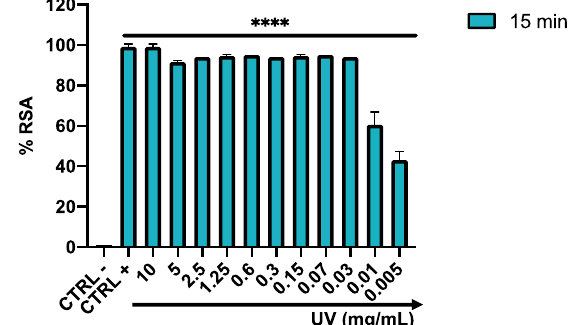
Figure 9. Free radical scavenging activity of Arctostaphylos uva-ursi leaf extract. Ascorbic acid (5 mg/mL) and Methanol represent the CTRL + and CTRL − , respectively. DPPH assay represents the mean ± standard deviation (SD) of three independent experiments. **** p -value < 0.0001; ANOVA: p- value < 0.0001; R squared = 0.9980.